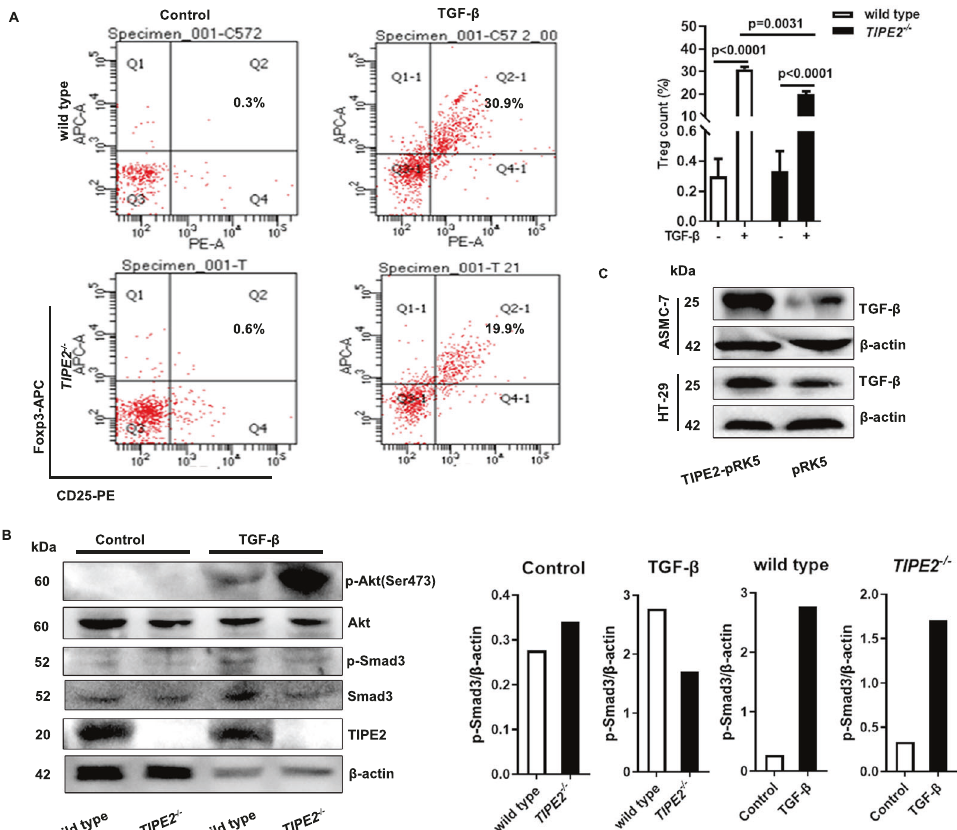
Fig. 4 Tipe2 -de fi ciency in naïve CD4 + T cells inhibits iTreg differentiation. A Showed a lower percentage of iTregs differentiated from Tipe2 - de fi cent naïve CD4 + T cells in vitro. Data were collected using BECKMAN COULTER CytoFLEXS, then analyzed using CytExpert. B Showed an increased level of p-Akt and decreased p-Smad3 in Tipe2 -de fi cent naïve CD4 + T cells with TGF- β stimulation. The images were analyzed using ImageJ software. C The overexpression of Tipe2 upregulated TGF- β expression in HT-29 or AMSC cells. Data are representative of three independent experiments and expressed as means ± SEM. Signi fi cant difference between two groups was determined using an unpaired two- tailed Student ’ s t -test. * P < 0.05, ** P < 0.01, *** P <